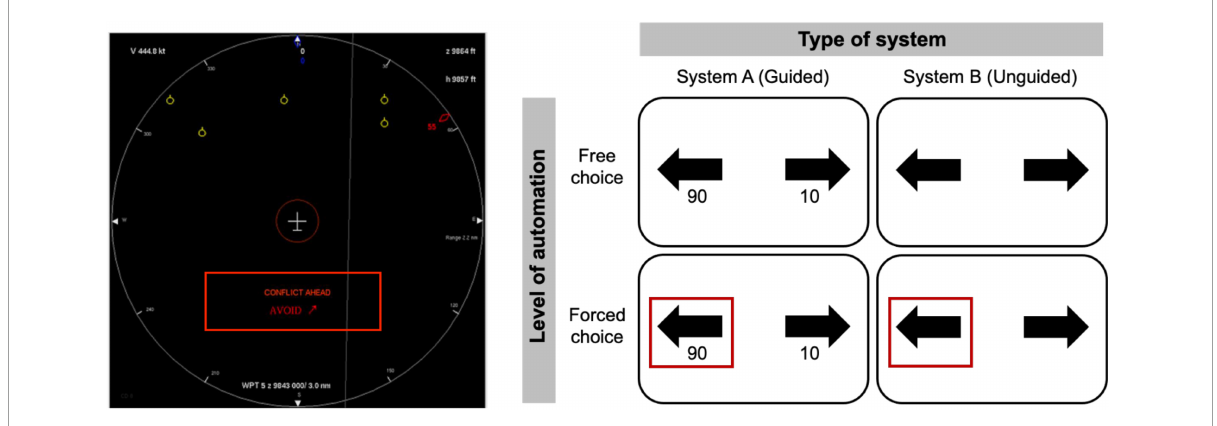
FIGURE4 (Left) Illustration of a type of explanation used in Le Goff et al. (2018). The message ‘AVOID’ appeared together with an arrow, and a mark on the large white circle indicated the direction selected by the system. (Right) Illustration of a type of explanation used in Vantrepotte et al. (2022). Participants interacted with two different systems: a system (System A) guiding the subject by returning its relative confidence (between 0 and 100) in each of the two possible answers, and a system (System B) returning nothing (no guidance). Reproduced from in Le Goff et al. (2018), with permission from Taylor & Francis. Reproduced from Vantrepotte et al. (2022), with permission from